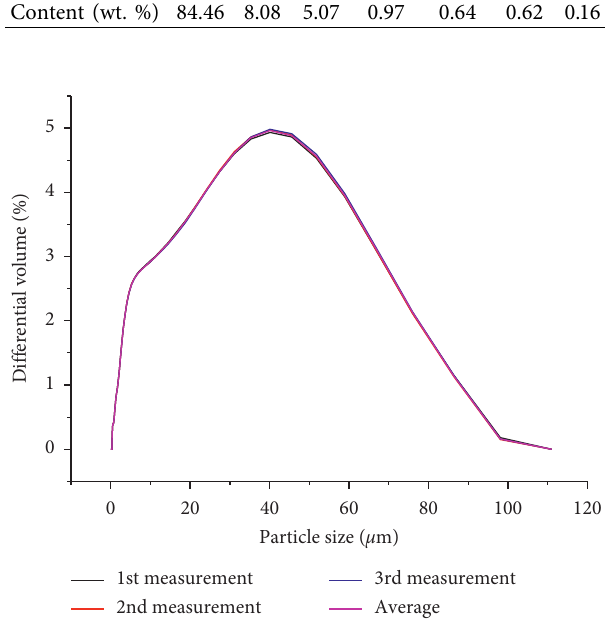
Figure 1: The particle size distribution of the dead-burned